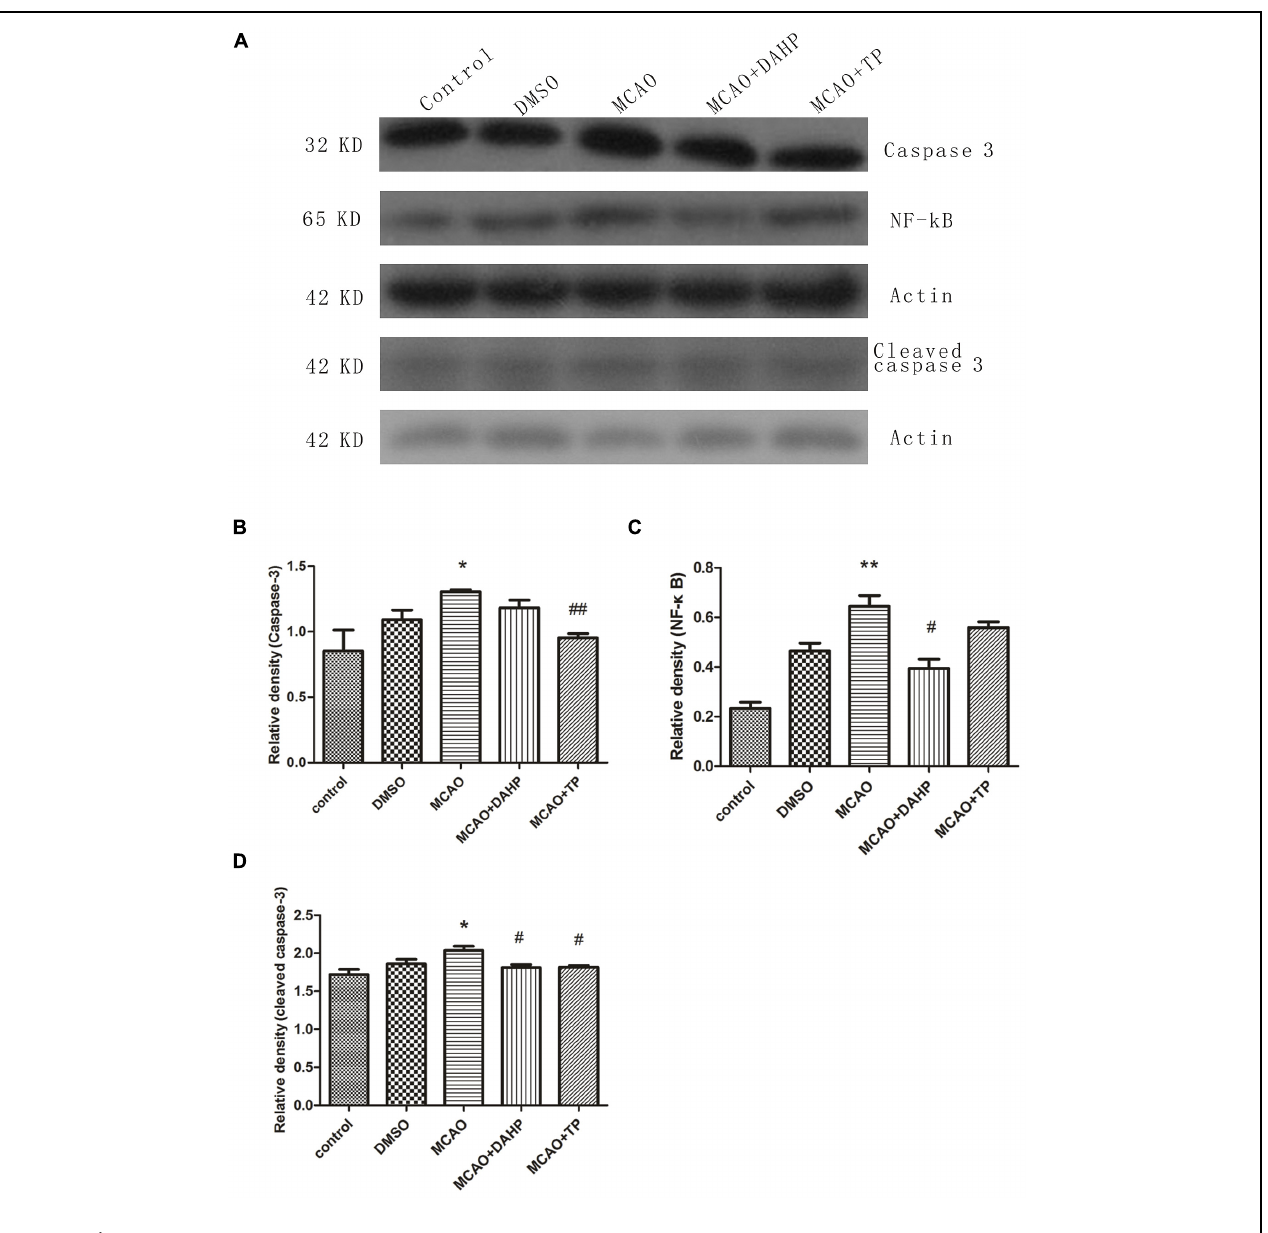
group. DAHP and TP treatment significantly reduced the expression of caspase-3, NF- κ B and cleaved caspase-3. ∗∗ P < 0.01 vs. control group; ∗ P < 0.05 vs. control group; # P < 0.05 vs. MCAO group; ## P < 0.01 vs. MCAO